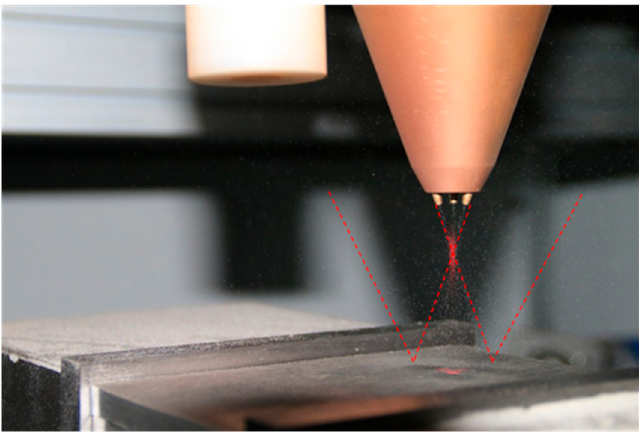
Figure 13. Temperature change curve near the molten pool.